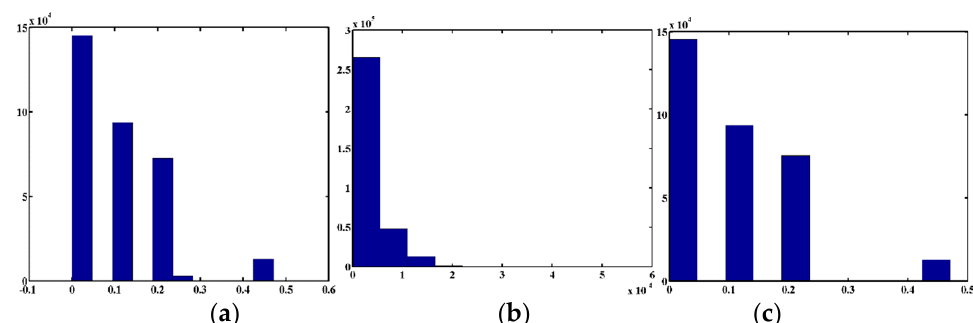
Figure 4. Histograms of spectral gradient of ( a ) the observed image, ( b ) underlying clean image, and ( c ) the stripe of WDCM in Figure 3.